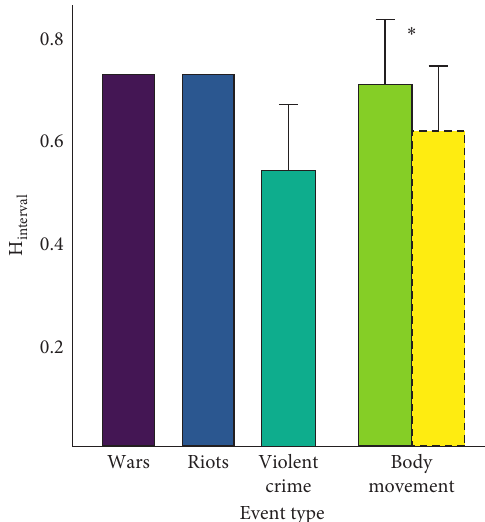
Figure 3: Scale-Independence of Aggression. ( H ) interval for the four levels of aggression (solid line bars). ( H ) argument (green bar, solid line) was in concordance with ( H )wars and ( H )riots, but signifi- cantly different from ( H ) affiliate (yellow bar, dotted